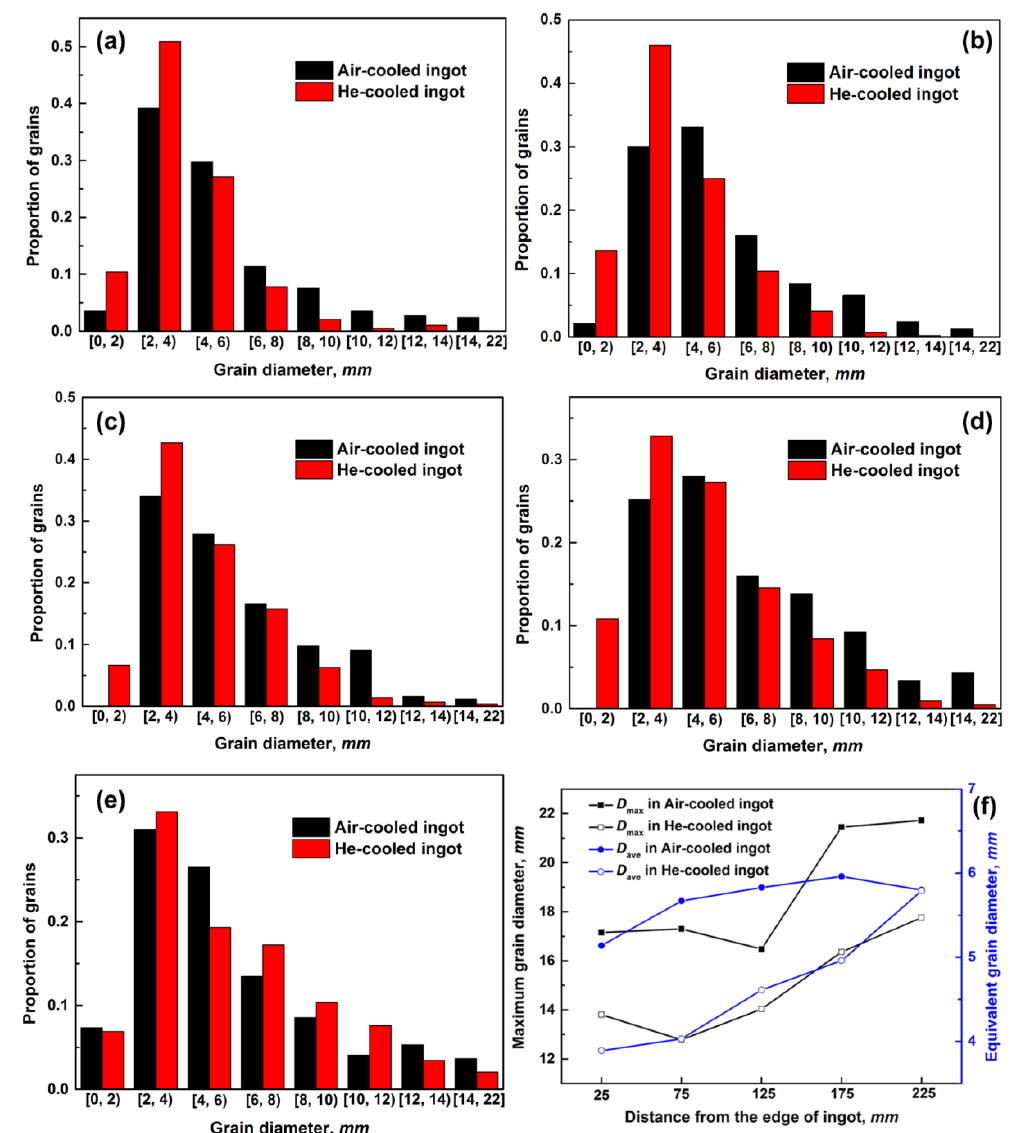
Figure 4. The statistic grain size distributions from the edge to the center of He- and Air-cooled NbTi ingots. ( a – e ) With the distances of 0–50, 50–100, 100–150, 150–200 and 200–250 mm, respectively; ( f ) the comparison of maximum ( D max ) and average ( D ave ) grain sizes in different distances of two